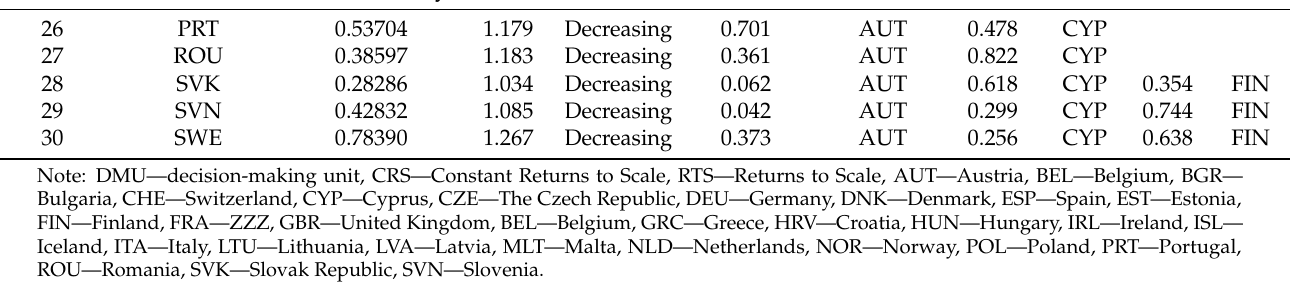
Table A4. Input-Oriented VRS Efficiency of EPS in 2013. Source: Authors’ calculations in DEAFrontier. DMU